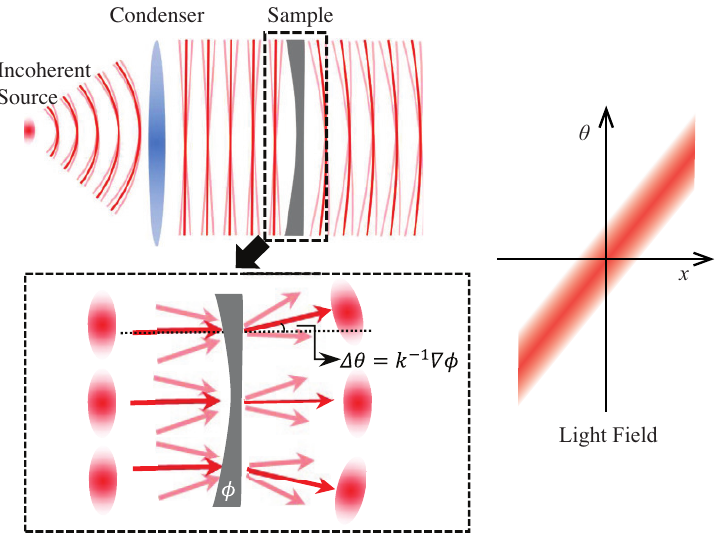
Figure 23. Light field representation of a slowly varying object under spatially stationary illumination. The sample exhibits angle-shift invariance: at each location, the direction of each incident ray shifts by the amount of object phase gradient; (Reprinted from Optics and Lasers in Engineering, 71, Chao Zuo, Qian Chen, Lei Tian, Laura Waller, Anand Asundi, Transport of intensity phase retrieval and computational imaging for partially coherent fields: The phase space perspective, 13, Copyright (2015), with permission from Elsevier